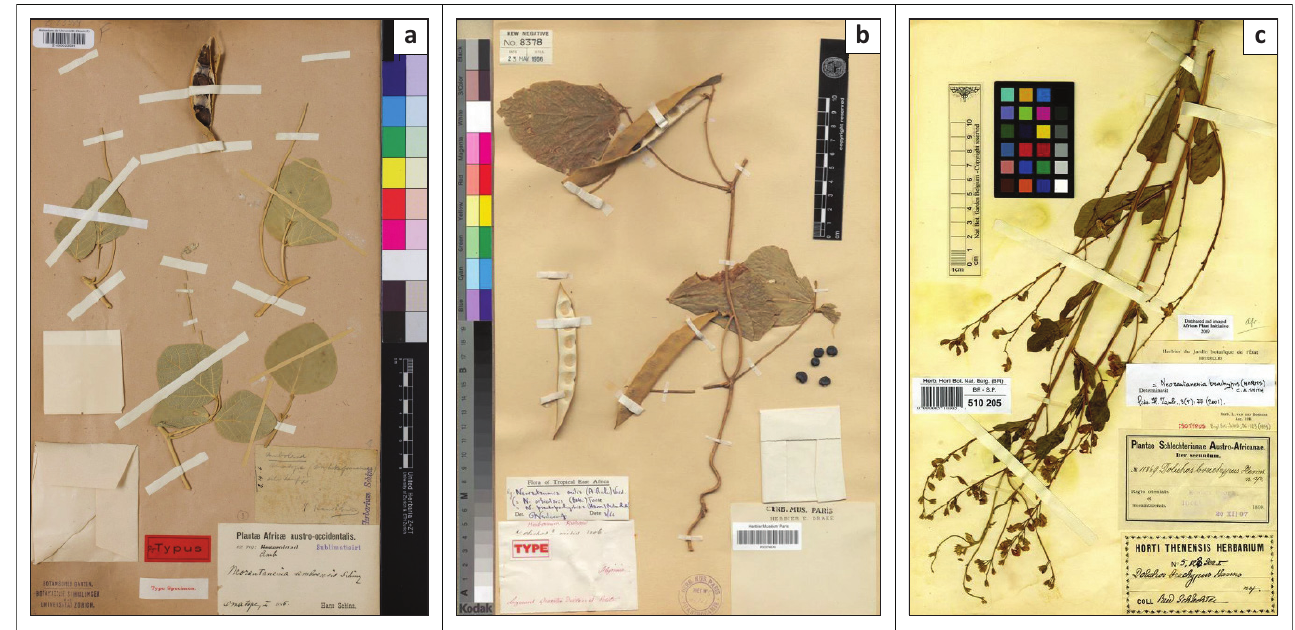
FIGURE 3: Type specimens of (a) N. amboensis ; (b) N. mitis ; (c) N.